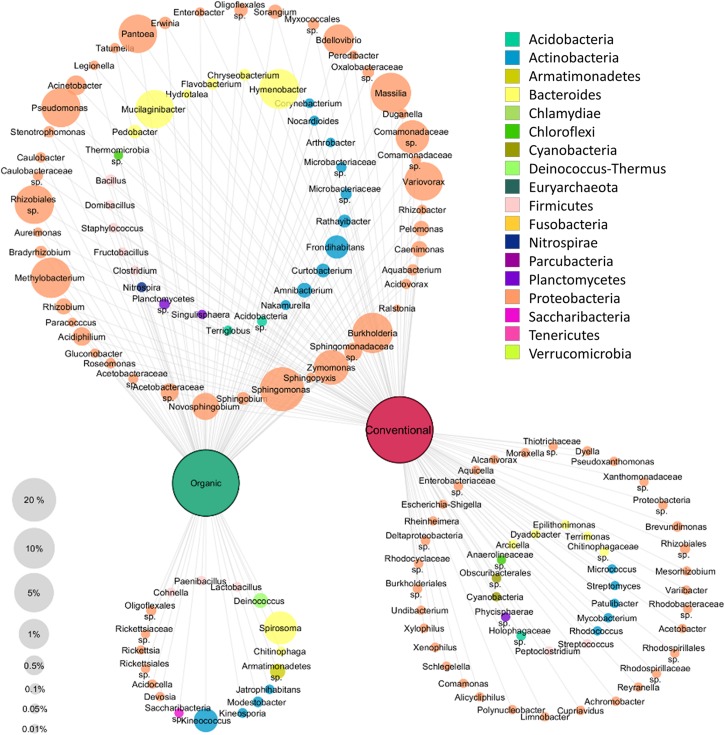
Core and specific microbiota for organic and conventional apples. Core microbiota (taxa occurring in 75% of all replicates) of each management group (conventional and organic) were combined for network analysis. To be included, taxa had to exhibit at least 0.01% abundance in the whole dataset. Node size correspond to relative abundance in the dataset as denoted in the legend on the bottom left, node labels display taxonomic identification of OTUs on genus level wherever possible and node color indicates appropriate phylum, as described in the legend on the top right.